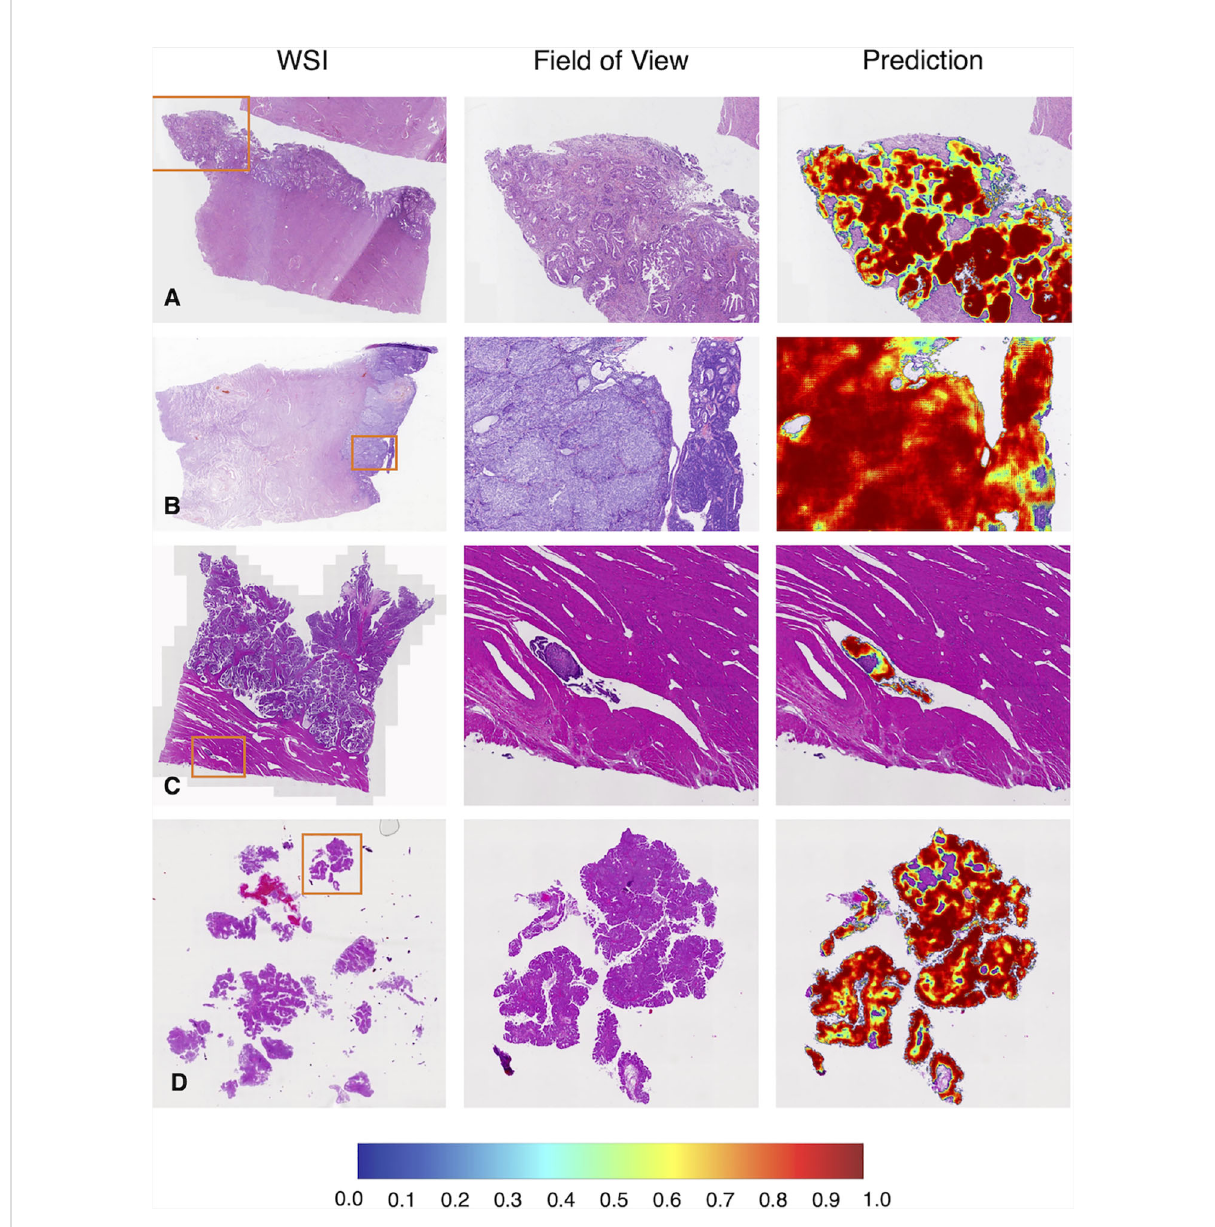
FIGURE 5 Representative examples in the test dataset from PUPH. (A) Low-grade EC. (B) High-grade EC. (C) Intralymphatic carcinoma thrombus. (D) Fragmented component of EC. WSI, whole-slide